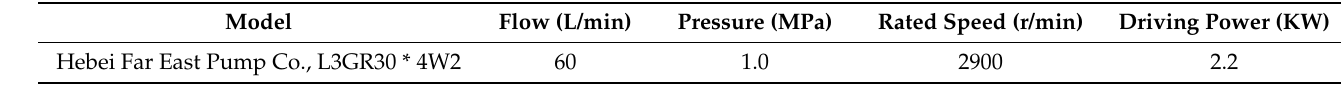
Table 2. Performance parameters of three-screw